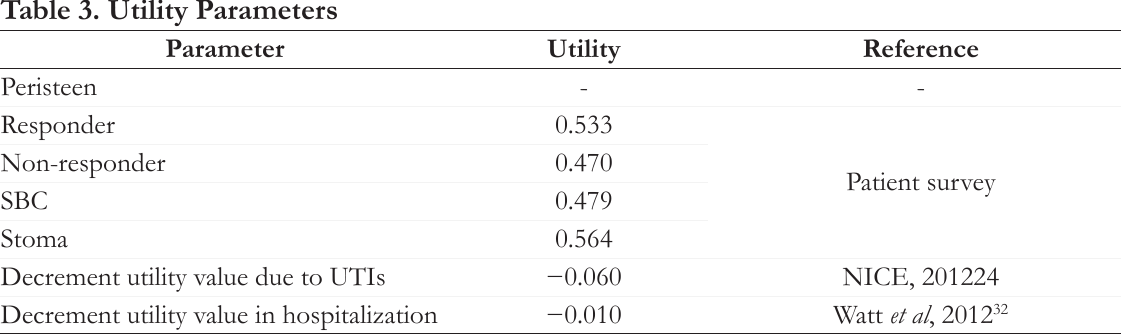
Table 3. Utility